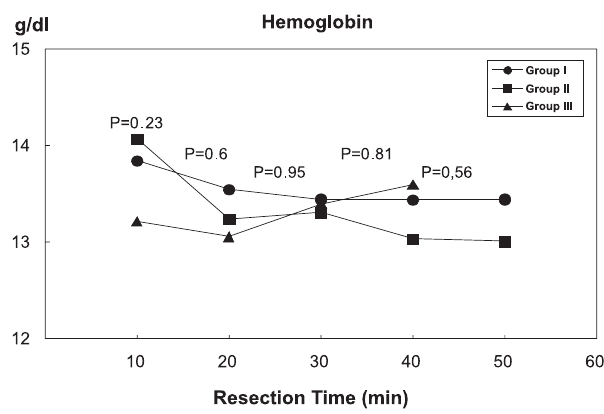
Figure 1A - Mean hemoglobin levels during TURP.